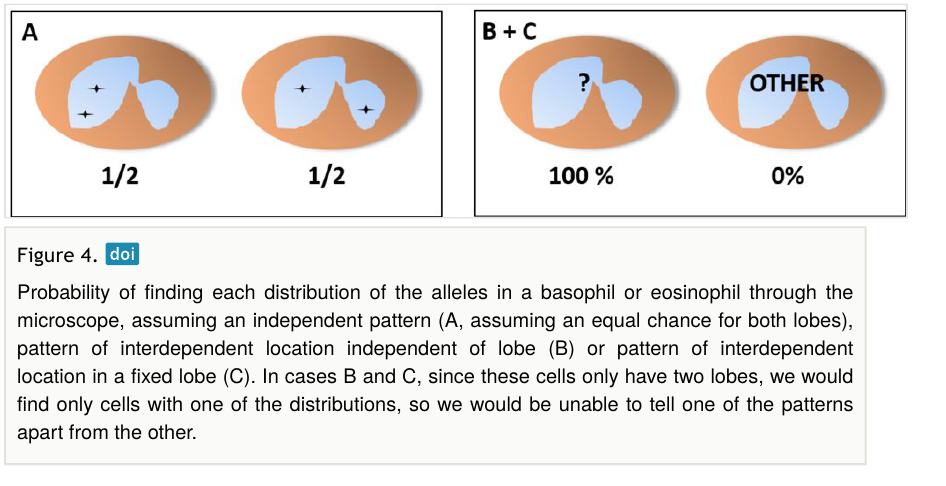
If the pattern of distribution of genes between lobes is random, every possibility has an equal chance to happen — or a consistently di ff erent chance, if some lobes are more likely to contain a higher amount of genes due to their larger size or similar factors. On the other hand, if this hypothesis is true, the distribution pattern would not be random. Instead, both copies of the same gene would most likely be always together in the same lobe or always in di ff erent lobes. In addition, if the position of the lobes is relevant, not only would the copies always be together or separated, but they would also be in the same nuclear position. So we can fi nd patterns with di ff erent percentages for the distributions of the loci (Figs 4, 5, 6).